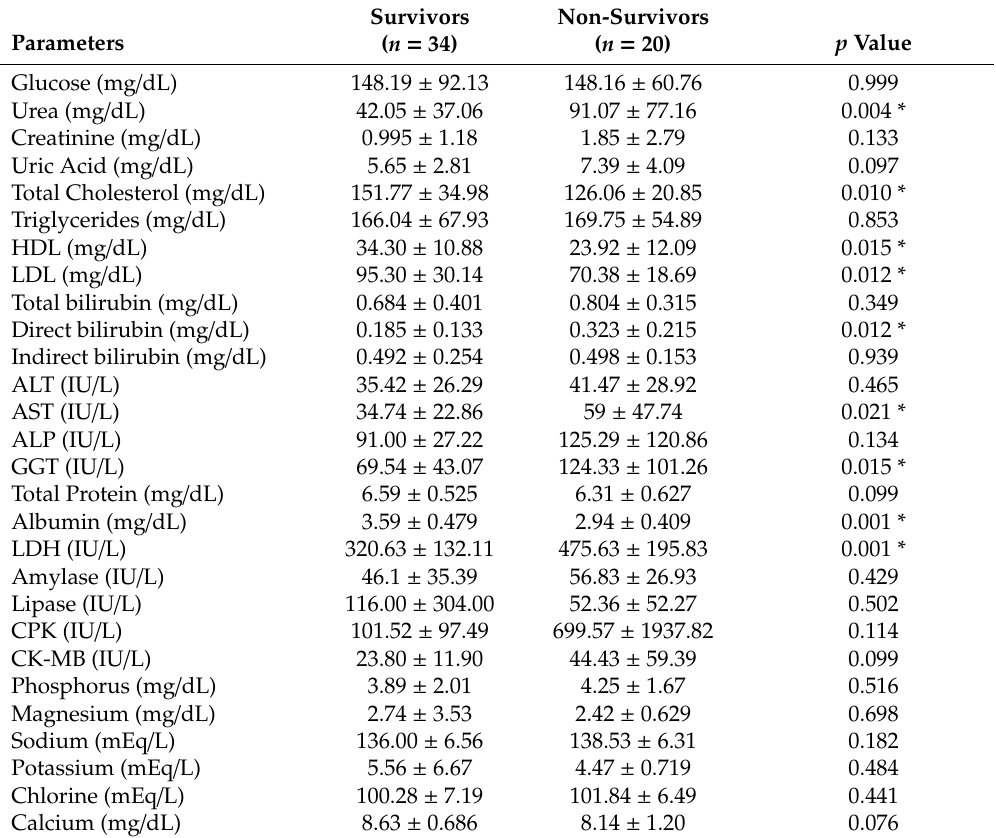
Table 2. Biochemical parameters, kidney function tests, and liver function tests at admission in hospitalized patients with severe Covid-19. Abbreviations: HDL, high-density lipoproteins; LDL, low-density lipoproteins; ALT, alanine aminotransferase; AST, aspartate aminotransferase; ALP, alkaline phosphatase; GGT, gamma glutamyl transferase; LDH, lactate dehydrogenase; CPK, creatinine phosphokinase; CK-MB, creatinine kinase myocardial band. Normality of data distribution